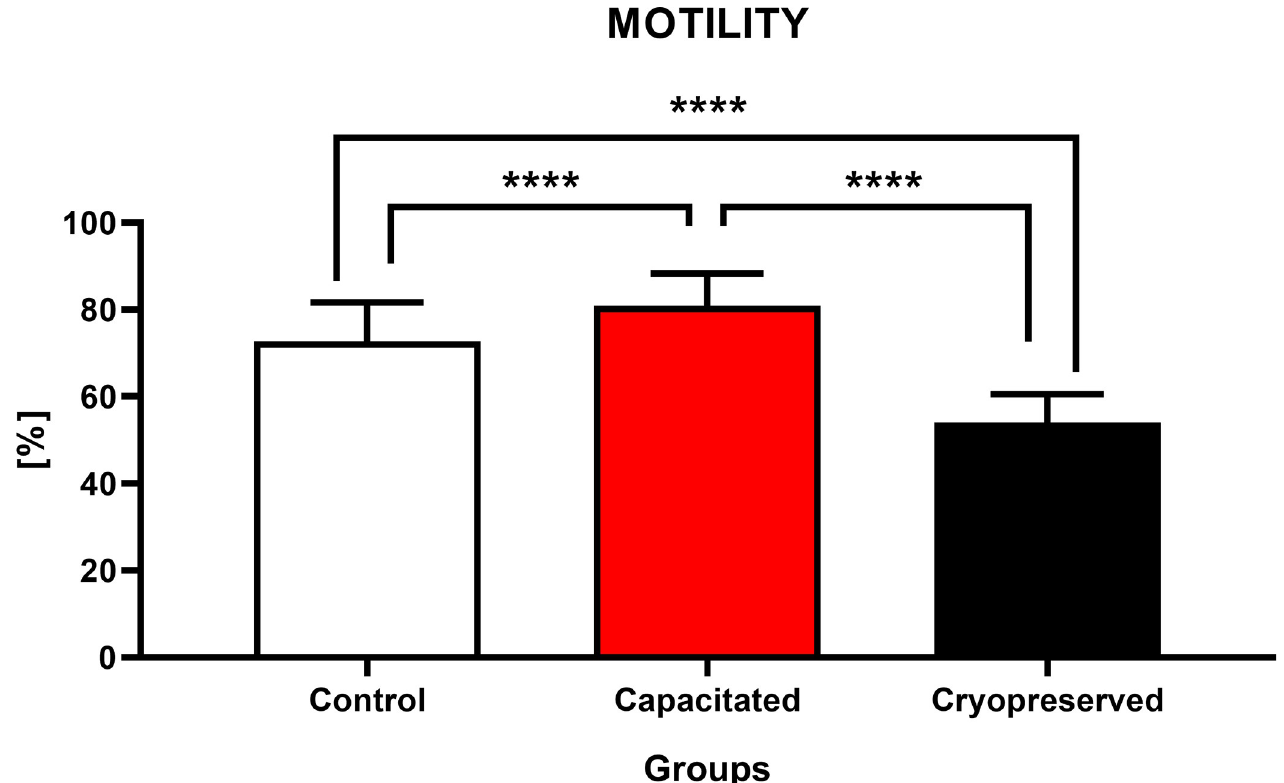
Fig 2. Motility of non-capacitated, in vitro capacitated and cryopreserved bovine spermatozoa. The values in the columns represent the proportion of motile spermatozoa (%) in each group ( ± SD). The results were obtained by comparing all groups with each other. The level of significance was set at � P < 0.05; �� P < 0.01; ��� P < 0.001; ���� P <